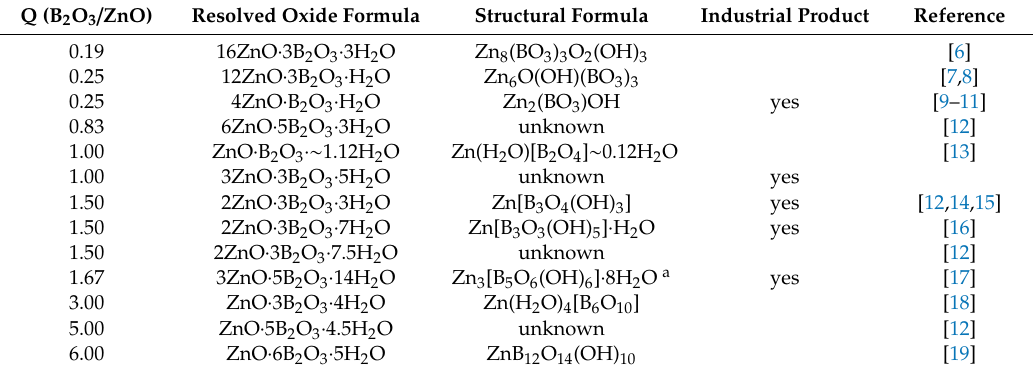
Table 1. Hydrated zinc